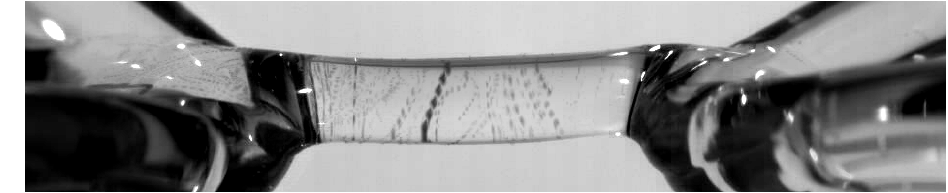
beaker (left) (from